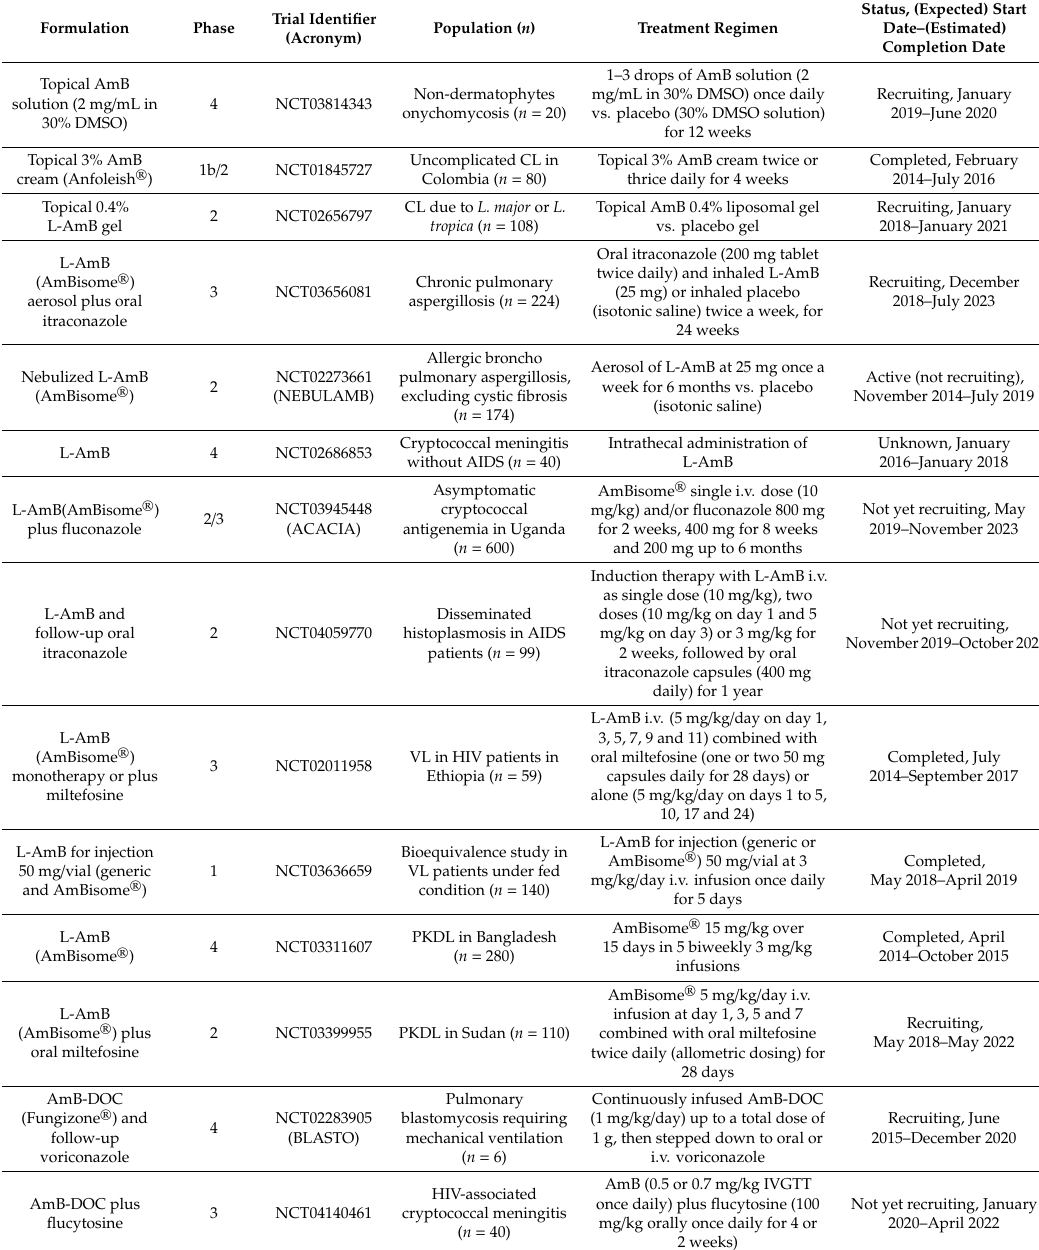
Table 3. Recently completed, on-going and expected clinical trials evaluating amphotericin B (AmB) safety and e ffi cacy against antifungal and antiparasitic